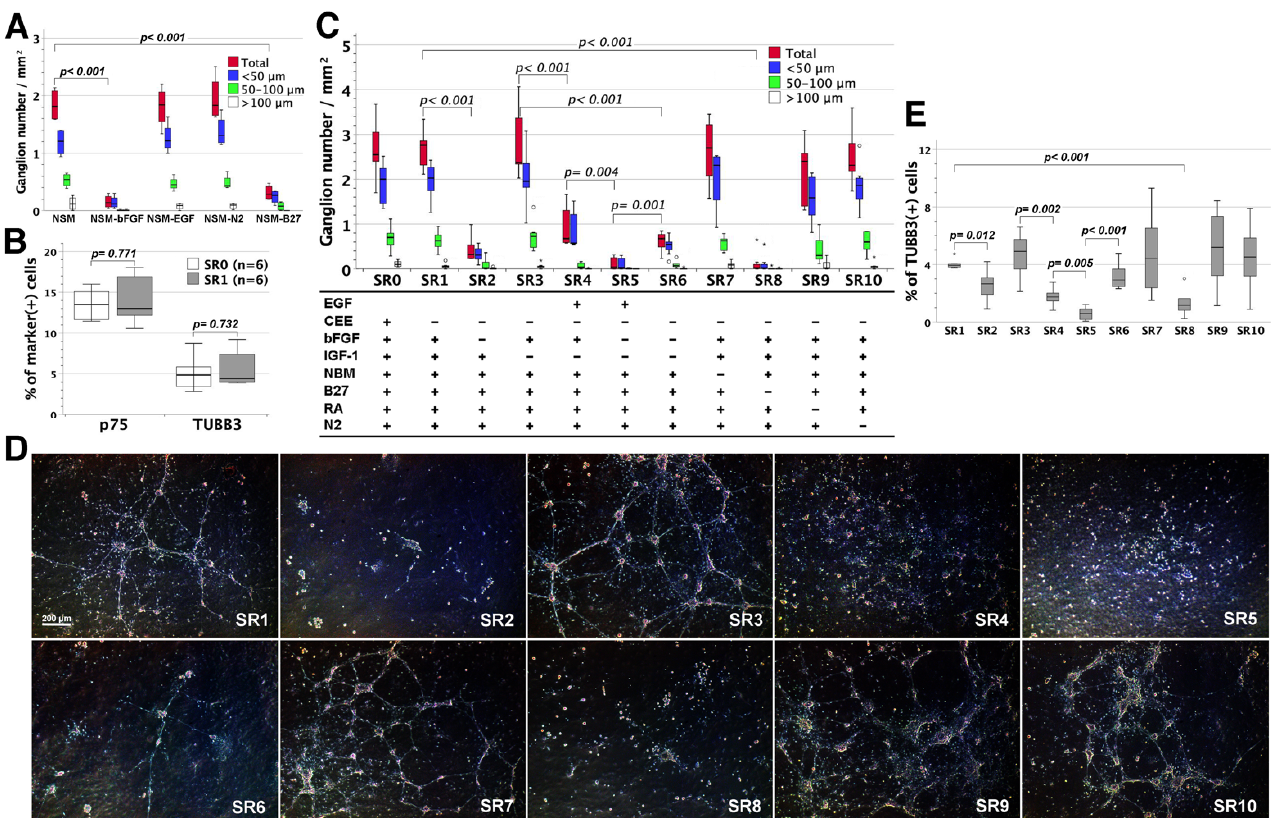
Figure 2. The influences of selective component elimination from NSM or SRM on the assembly of neurospheres or neural networks. Enterocytes (2 × 10 5 ) were non-adherently grown in 6-well plates flooded with NSM, SRM or their modifications by selective component elimination. Enteric neurospheres (or ganglia) were enumerated and analyzed after 7-day cultivation. ( A ) Comparison was made to total neurosphere (neuriteless ganglion) number (the added numbers of neurospheres sized <50 µ m, 50–100 µ m, and >100 µ m) between NSM and its indicated modifications ( n = 4 for each group). Selective elimination of bFGF (NSM-bFGF) or B27 (NSM-B27) from NSM significantly reduced enteric neurospheres ( t -test), whereas EGF or N2 omission (NSM-EGF or NSM-N2) made no change to neurospherogenesis. ( B ) Cultivated enterocytes in original SRM (SR0) and CEE-free SRM (SR1) were trypsinized, intracellularly stained with fluorescence-conjugated anti-p75 and anti-TUBB3, and analyzed by flow cytometry. SR0 and SR1 did not differ in the fractions of p75 + ENSCS and TUBB3 + neurons. ( C ) SRM was modified by selective elimination of one specific component or additional EGF supplementation as shown ( n = 7 for each group). Comparison was made to total ganglion number of SR0 vs. SR1, SR1 vs. its indicated modifications (SR2, 3, 7–10) or two modified conditions that varied in only one supplement (SR3 vs. SR4, SR4 vs. SR5, SR5 vs. SR6, and SR2/SR3 vs. SR6). The p -values of <0.05 ( t -test) were shown in the figure. Outliers (circle) and extremes (asterisk) were values of 1.5–3 times and more than 3 times interquartile ranges from the end of a box, respectively. ( D ) The images of ENSC development were taken live on day 7 in a representative set of experiments using the same batch of enterocytes. Day 7 cells in SRM and its relevant modifications ( n = 6) were analyzed for TUBB3 + neurons by flow cytometry after intracellular staining. Comparison was made to TUBB3 + neuron fractions between the two groups as indicated above in ( C